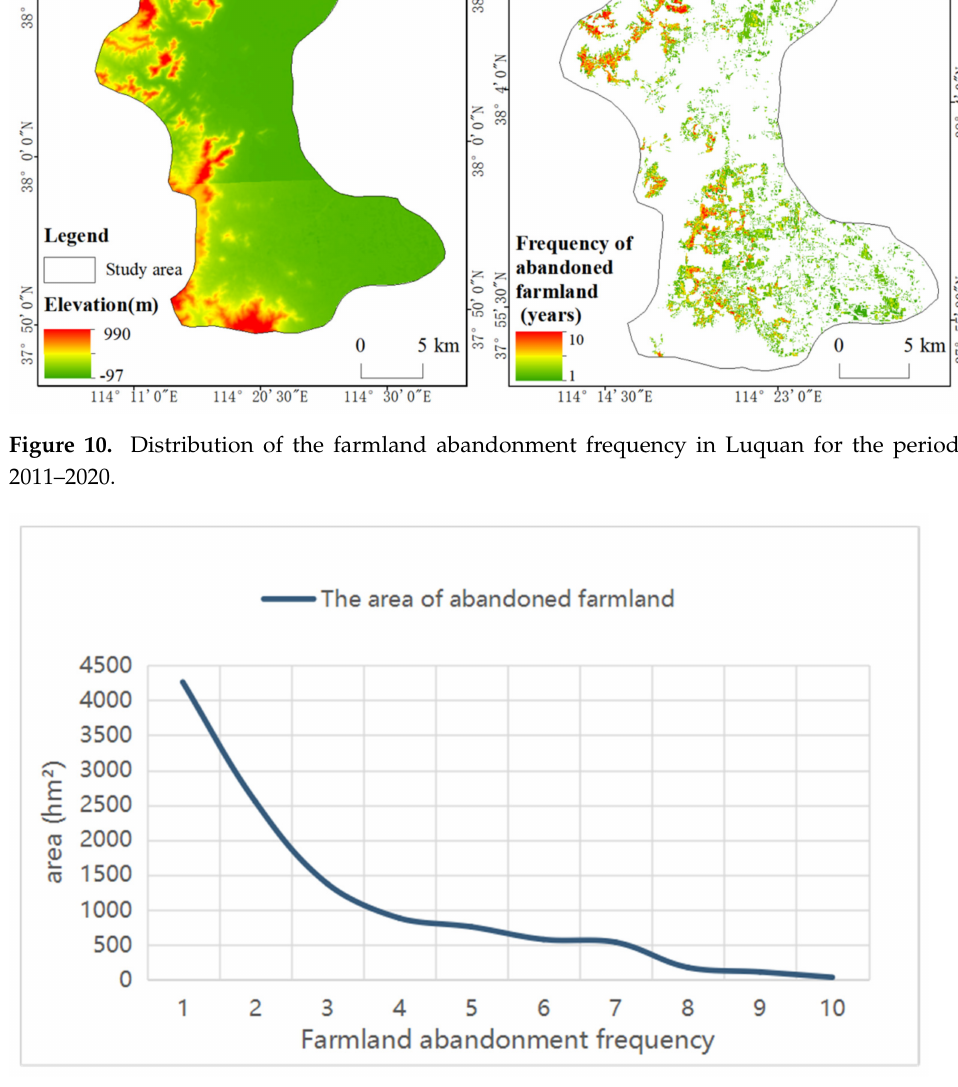
Figure 11. Farmland abandonment frequency in Luquan for the period of